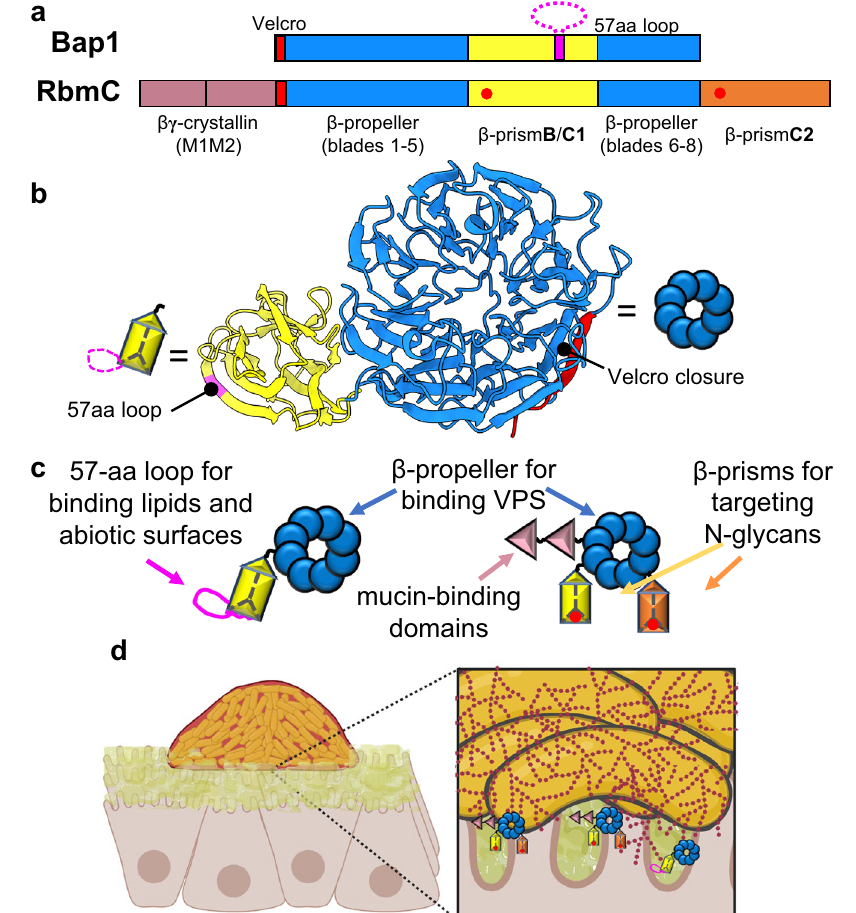
Fig. 1 | Bap1 and RbmC contain modular and overlapping domains for surface adhesion.a SchematicofBap1andRbmCstructuraldomains.Reddotscorrespond to the positions of the N-glycan binding pockets. b Crystal structure of Bap1 without the 57aa loop and the corresponding cartoon for each domain. The posi- tion of the 57aa loop (magenta) and the β -strand from β -propeller blade 1 that contributestothe Velcroclosure(red)areindicated. c Schematicandhypothetical